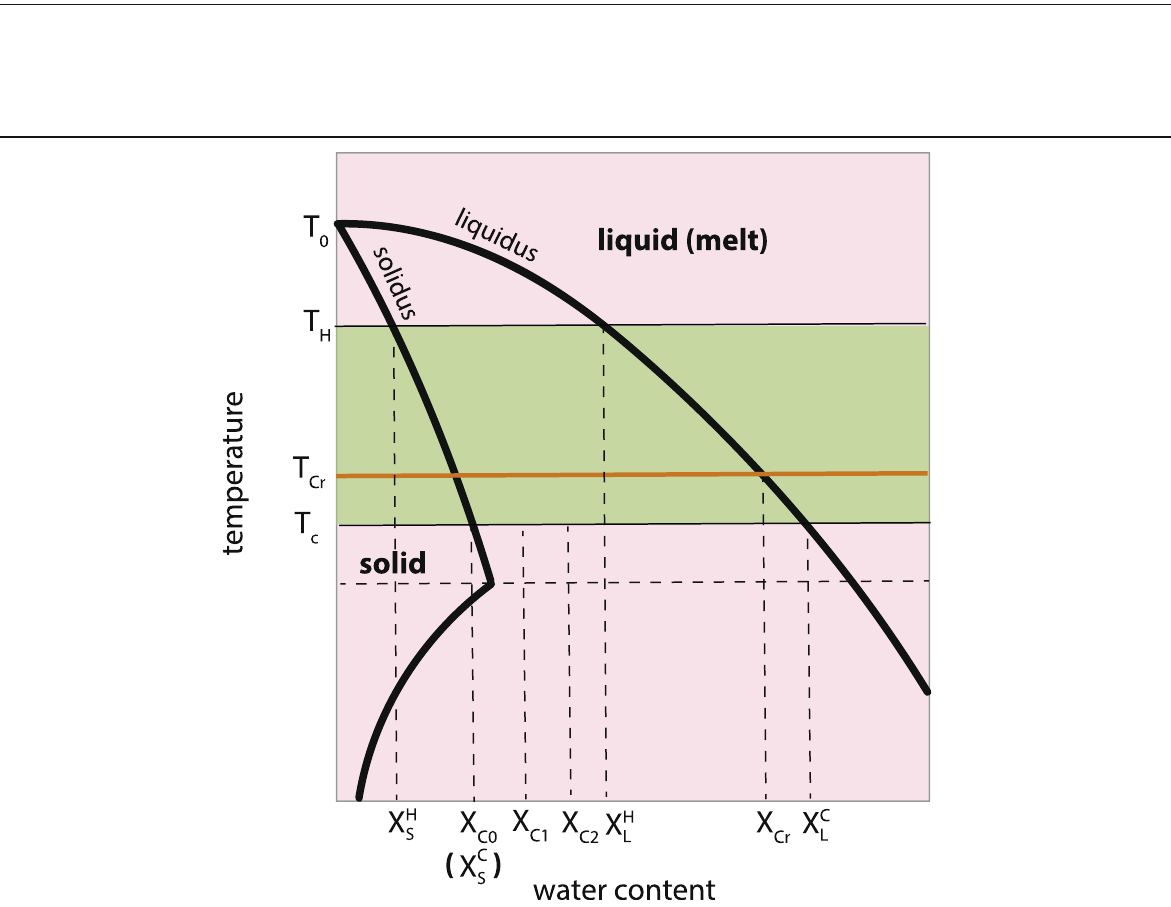
Fig. 10 A schematic phase diagram at ~ 410 km. A green region represents temperature distribution. T H , C is temperature in the hot ( H ) or the cold ( C ) regions respectively. T Cr is temperature at which the melt has high enough water content and is buoyant. X H ; C content at the solidus and liquidus in the hot or the cold region respectively. X C 1 is the minimum water content in the transition zone where the melt will ascend (~ 0.2%). X C 2 is the water content above which hydrated materials above the MTZ are buoyant to form a plume (~ 1%; Supplementary